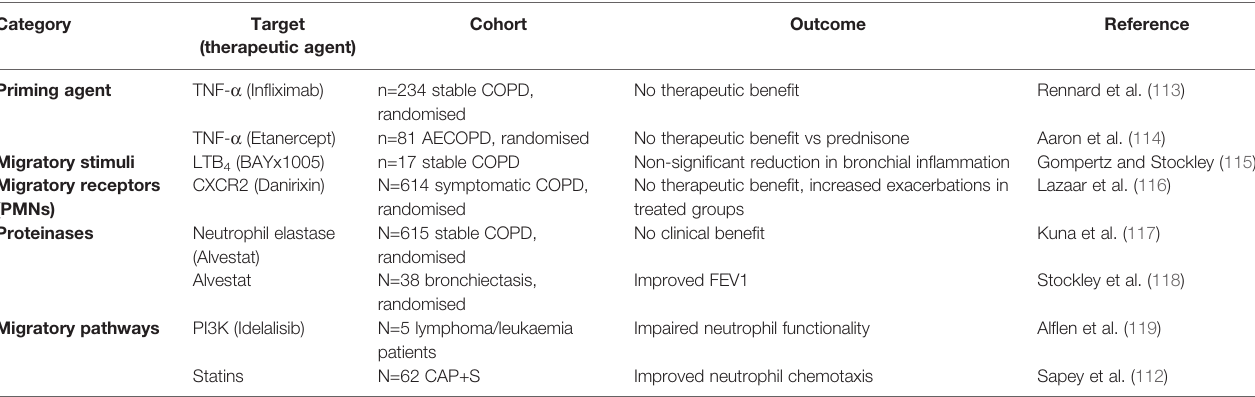
TABLE 1 | Therapeutic agents that target leukocyte function and their clinical trial